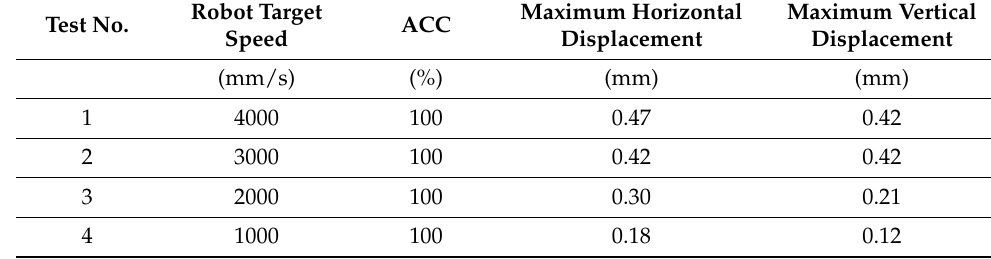
Table 4. Maximum gripper displacement for selected robot speeds. Test No.